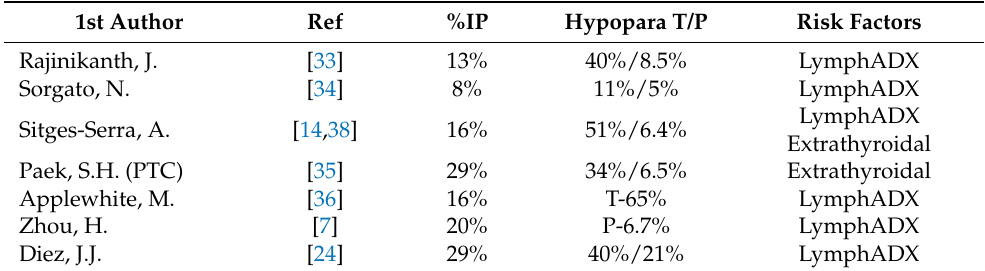
Table 1. Rates of inadvertent parathyroidectomy (%IP) and associated hypoparathyroidism (Tran-